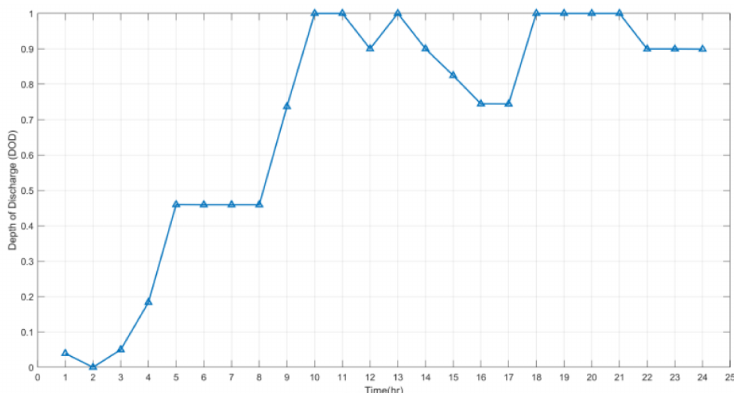
Figure 8. The depth of discharge of BESS in Scenario 2.